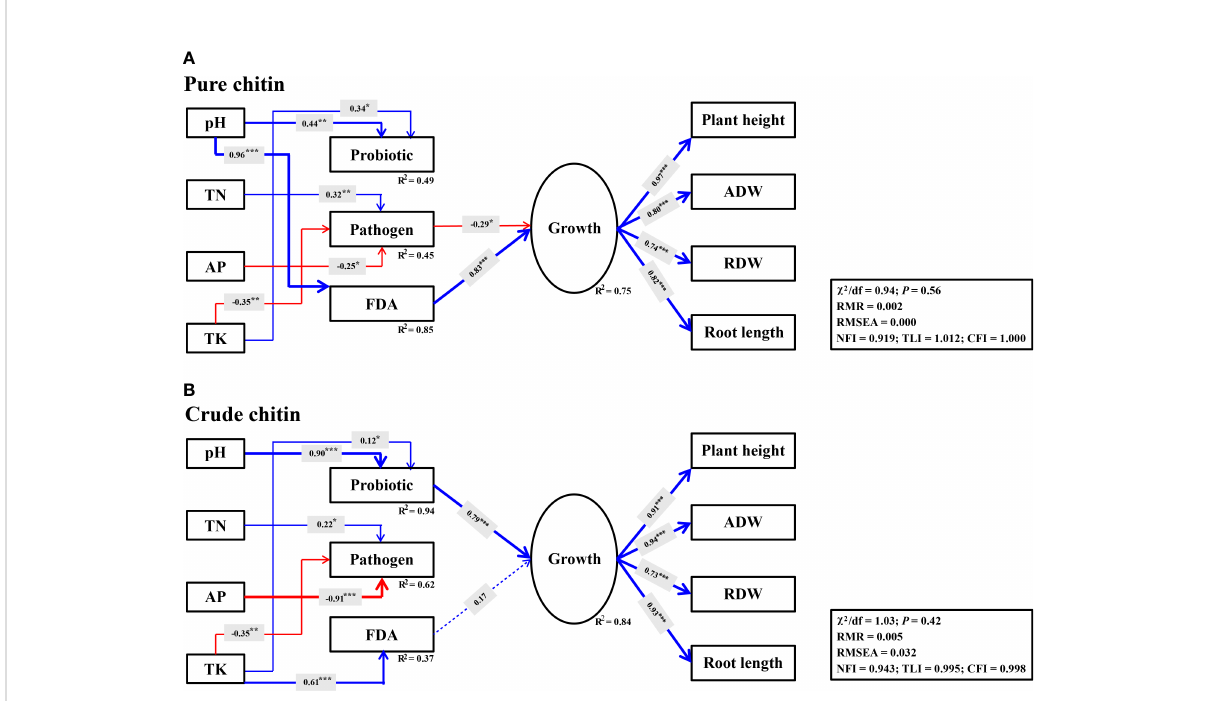
FIGURE 7 Structural equation models (SEMs) describing the direct and indirect effects of soil properties, probiotic, potential plant pathogens and FDA on soybean growth under pure (A) and crude (B) chitin amendments. The probiotic represent potentially bene fi cial bacteria and fungi. The latent variable for soybean growth are indicated by plant height, aboveground dry weight (ADW), root dry weight (RDW) and root length. Solid and dashed lines indicate signi fi cant and insigni fi cant relationships, respectively. Arrow width indicates the effect strength, with blue and red indicating positive and negative effects, respectively. R 2 means the proportion of variance explained. *** P < 0.001; ** P < 0.01; * P <